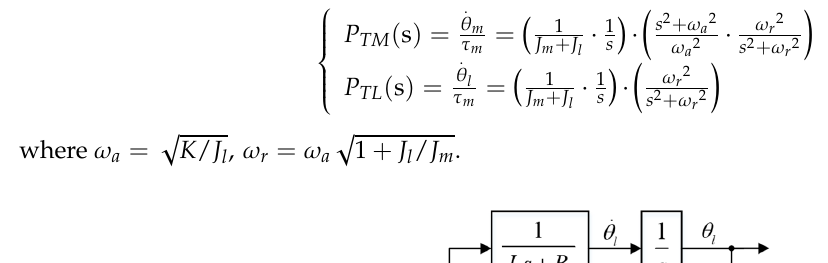
Figure 2. The two-inertia model block diagram of the modular drive joint.